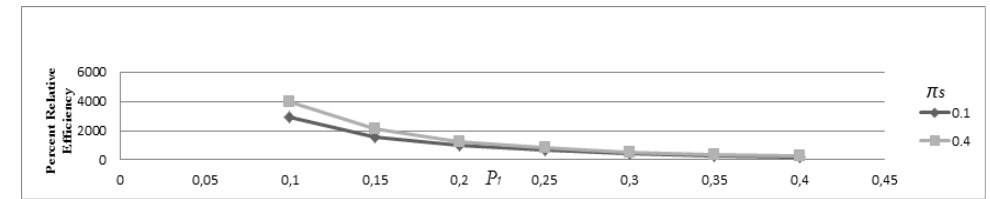
π ∗ with respect to Kim and c